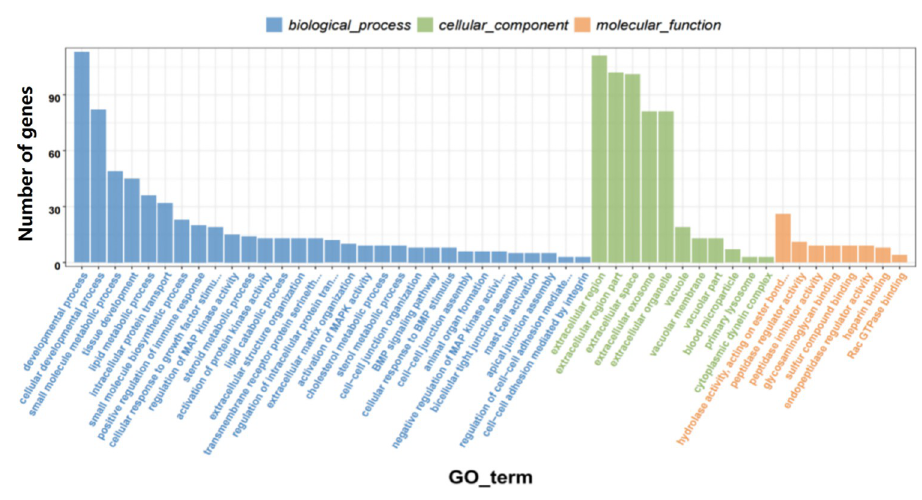
Fig 4. GO analysis of DEGs.